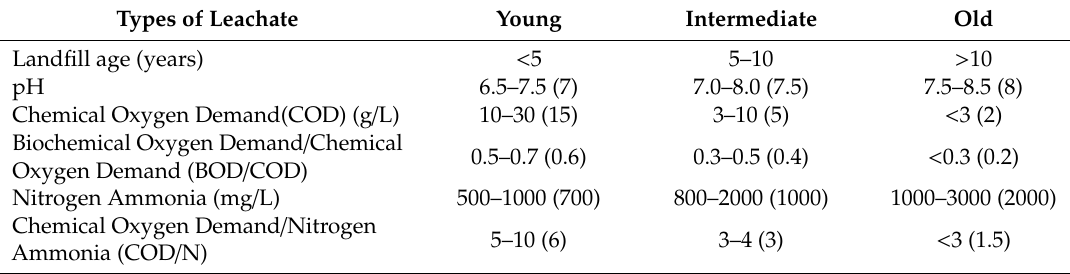
Table 1. Properties of leachate at di ff erent